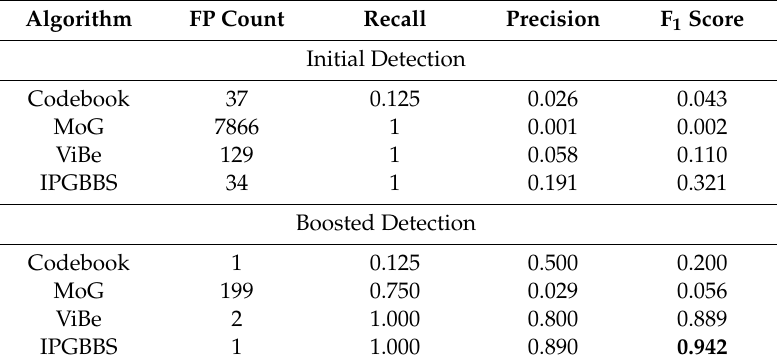
Table 2. Accuracy assessment of four moving object detection